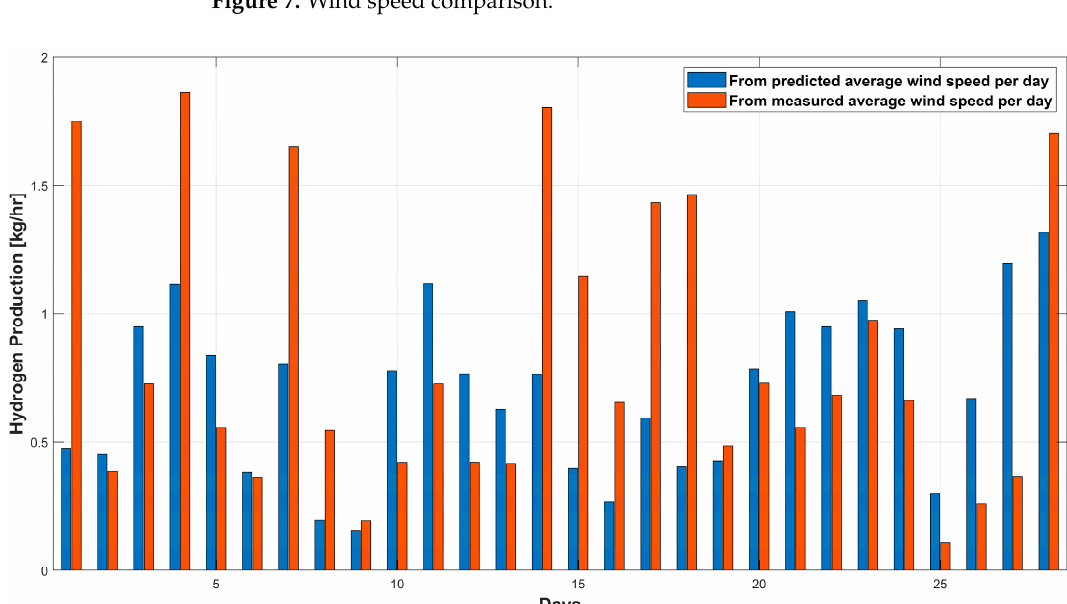
Figure 8. Hydrogen production from daily average wind speeds.